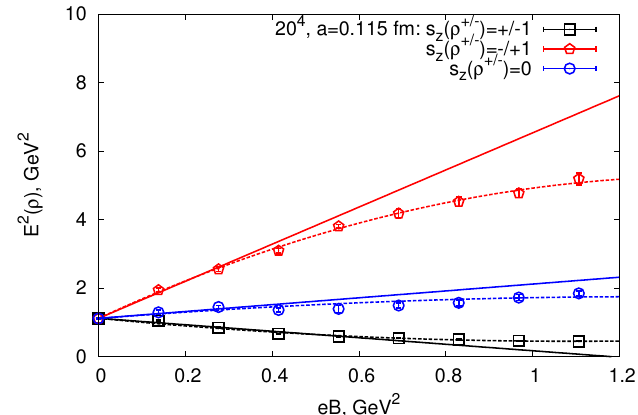
Figure 7. The energy squared of the charged (cid:26) meson for various spin projections s z = 0 ; (cid:6) 1 depending on the magnetic (cid:12)eld value for the lattice volume V = 20 4 , the lattice spacing a = 0 : 115 fm and the pion mass m = 535(4) MeV. The solid lines correspond to the (cid:12)ts of the lattice (cid:25) 0 data obtained with the use of formula (3.2), the dashed lines are the (cid:12)ts of the lattice data by (4.1).